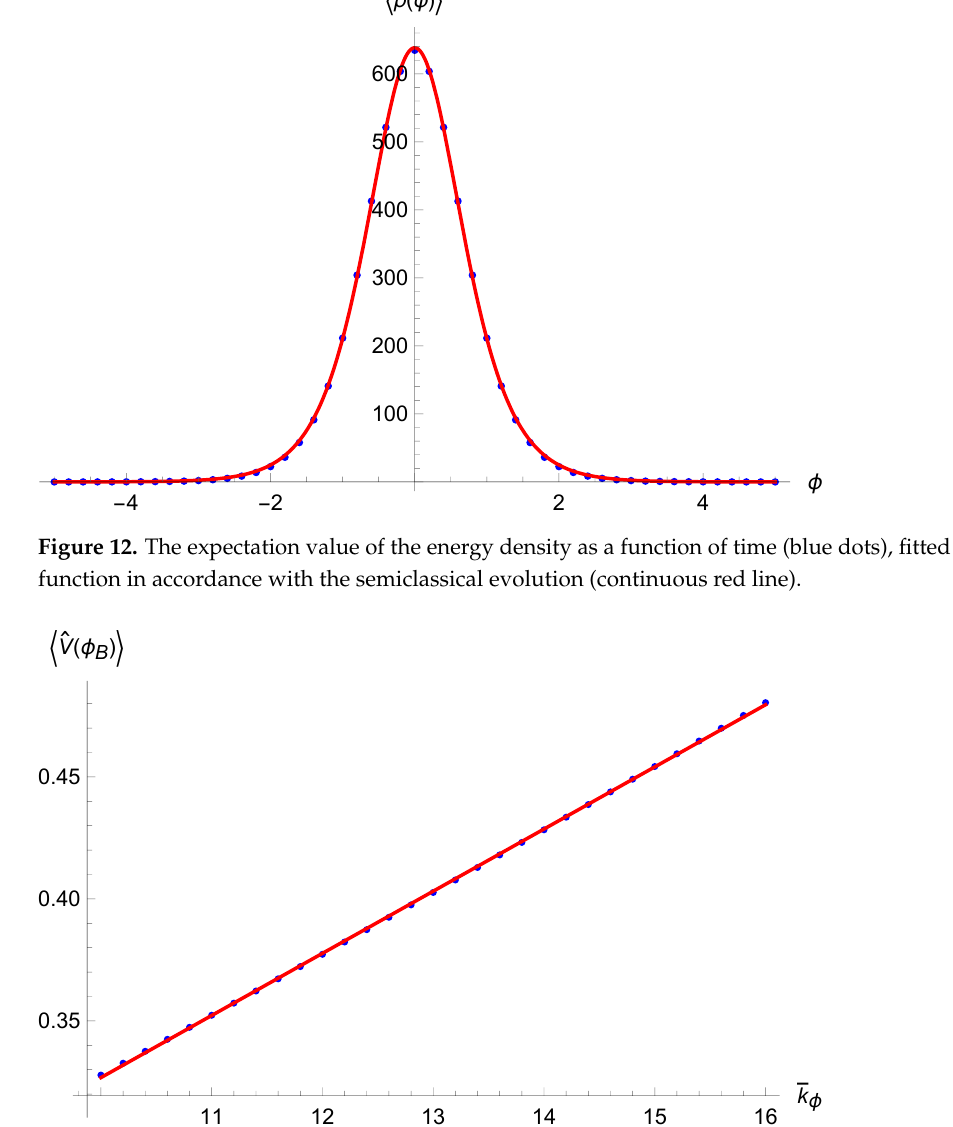
Figure 13. The expectation value of the Universe volume at the time φ B of the Bounce as a function of k φ (blue dots), fitted with a function in accordance with the semiclassical evolution (continuous red